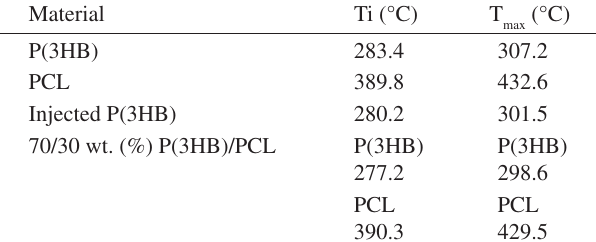
Table 2. Thermogravimetric data - onset (T (T ) max